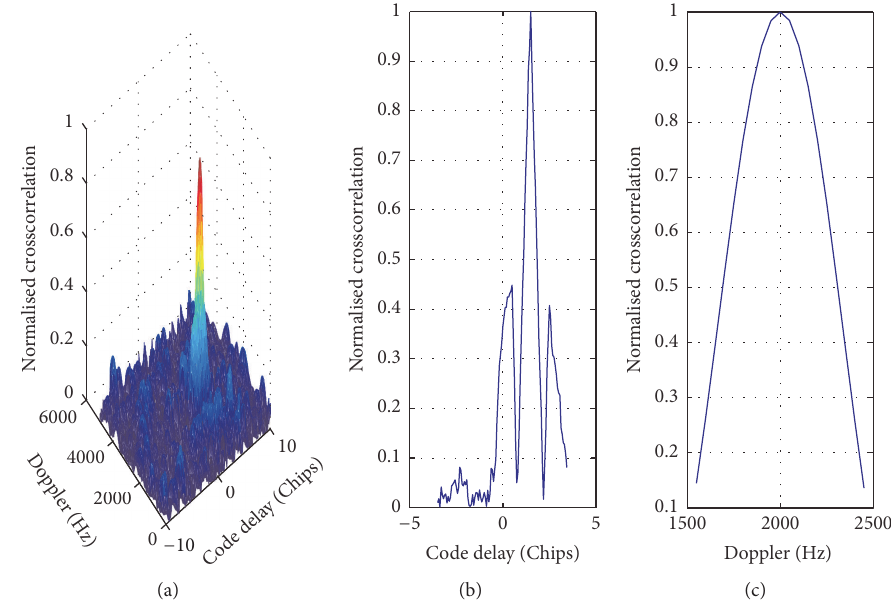
Figure 16: Correlation peaks after interference suppression by DST-MPDR beamformer for scenario 1.